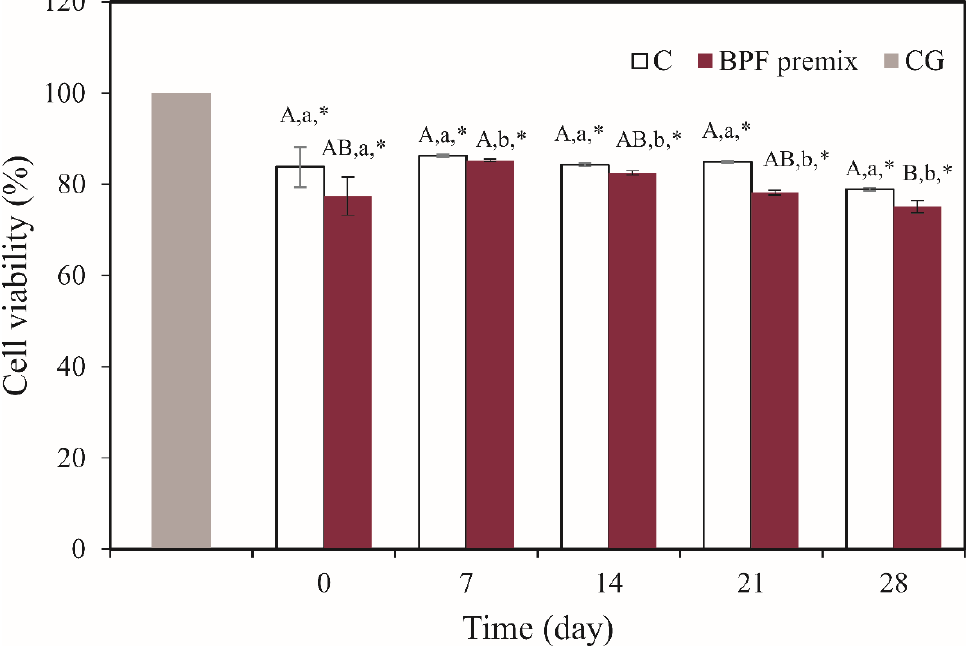
Figure 4. Inhibition rates of HCT116 cells treated for 24 h with supernatants from yogurts prepared by applying neat starter cultures (control (C)) and BPF premix. CG; cell growth control. Values are presented as mean ± standard error ( n = 3); AB a significant difference in means during time within the same sample; ab a significant difference in means between samples at the same time according to the HSD test ( p < 0.05); * a significant difference in means between all samples and CG according to the Dunnett’s test ( p < 0.05).